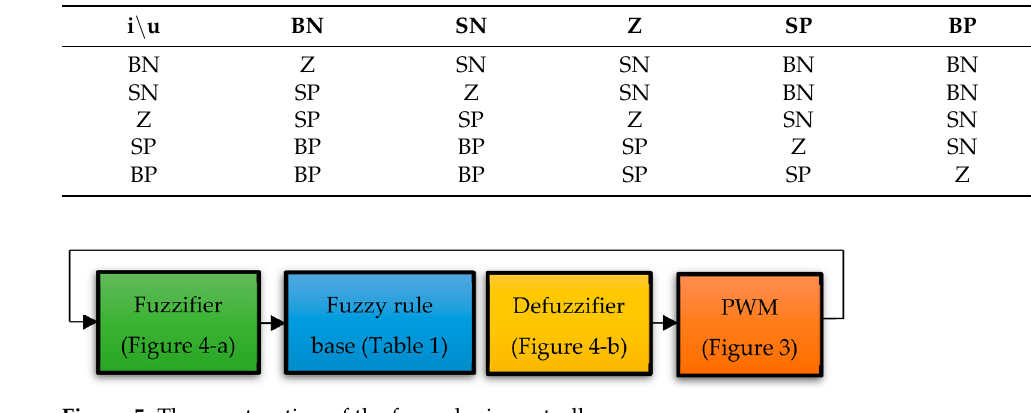
Figure 5. The construction of the fuzzy-logic controller.